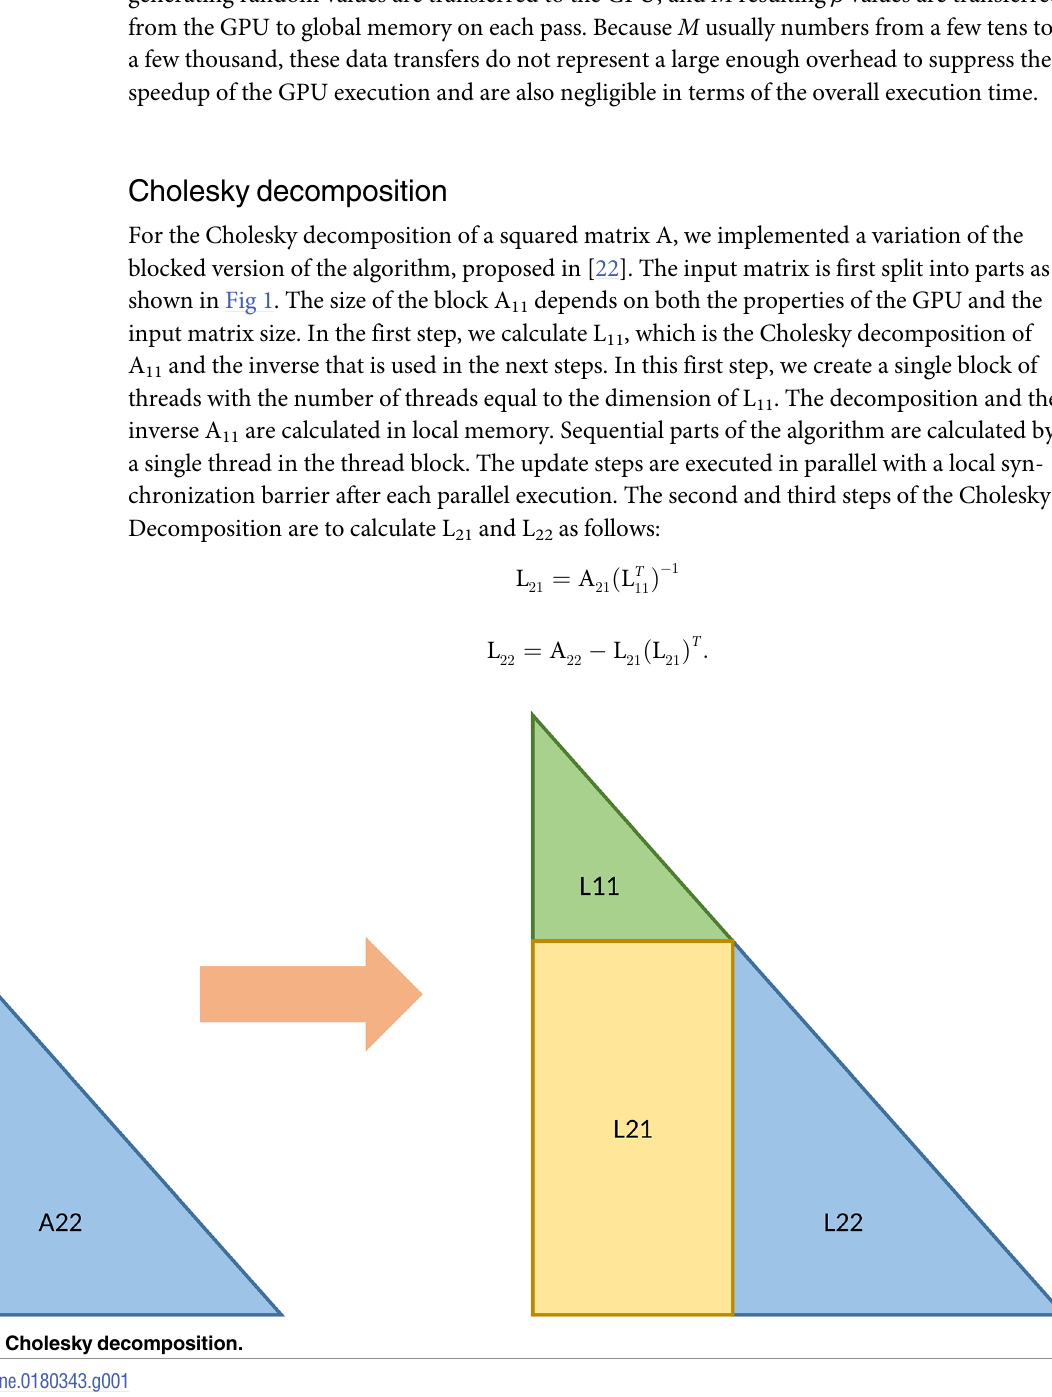
PLOS ONE | https://doi.org/10.1371/journal.pone.0180343 June 28,